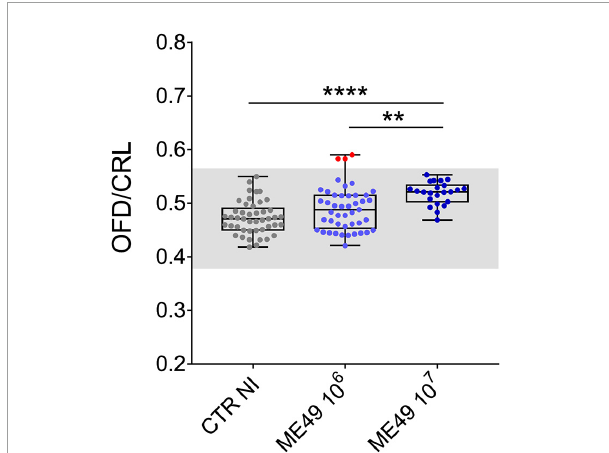
FIGURE4 Impact of infection on fetal cephalic proportion relative to body size during maternal-fetal transmission of T. gondii in Swiss Webster mice. Data expressed as the ratio between occipital-frontal diameter (OFD) and crown-to-rump length (CRL). The gray region corresponds to the range defined by three SD in relation to the mean values of uninfected controls. Red dots indicate three conceptuses with OFD/CRL values compatible with macrocephaly. n = 23–45 samples from at least two independent pregnant dams for each condition. Data are presented as median ± interquartile range. One-way ANOVA with Tukey’s multiple comparisons test was employed. ** p < 0.01; **** p < 0.0001.